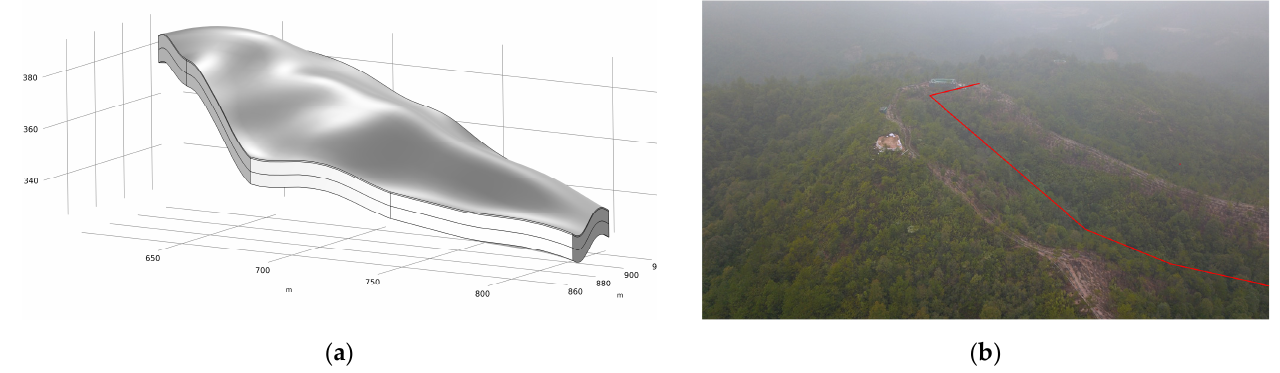
Figure 6. Test stope: ( a ) test stope assembly model; ( b ) test stope photos.